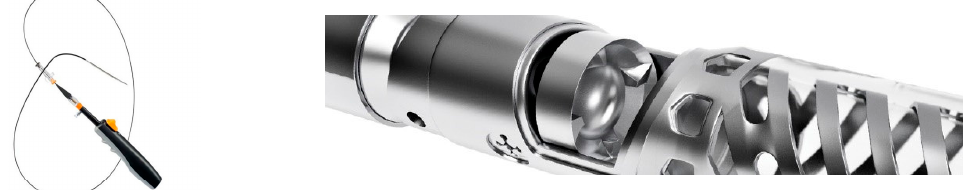
Figure 6. HawkOne TM Directional Atherectomy System. © 2020 Medtronic. All rights reserved. Used with the permission of Medtronic.